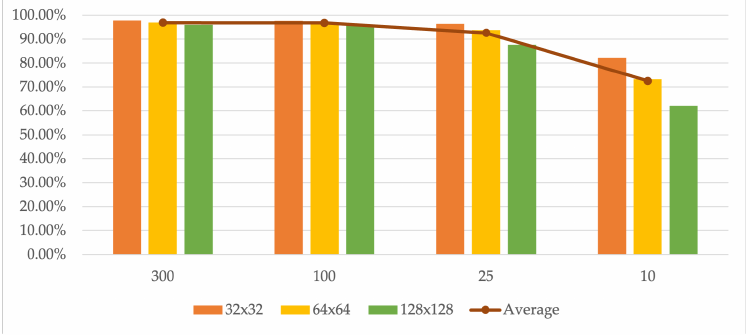
Figure 13. Accuracy with respect to different On/Off ratios and different array